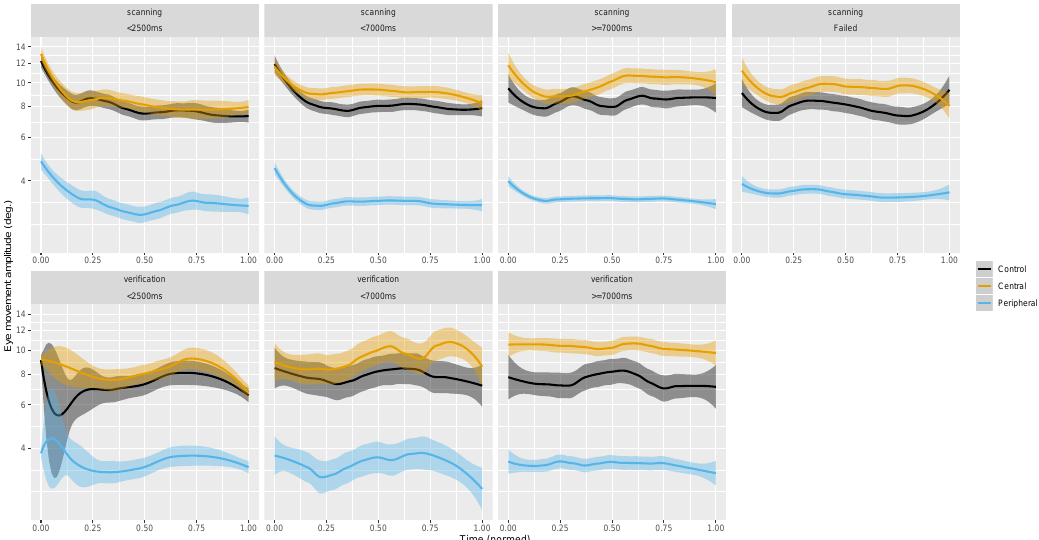
Figure A4. Time-course of average eye movements amplitude during saccades as a function of search phase (trial duration subgroups do not overlap). Ribbons show 95%CI. Control condition appears in black, central in orange and peripheral in